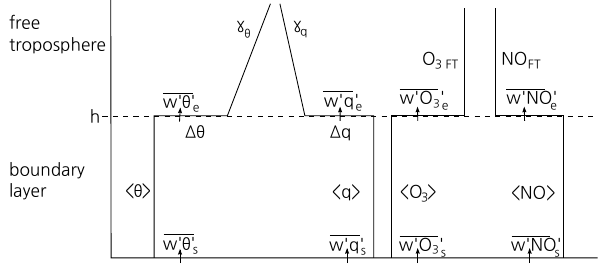
Figure 2. Typical mixed-layer profiles of potential temperature ( θ ), specific humidity ( q ) and chemical species (in this case O 3 and NO). Also surface and entrainment fluxes of heat, moisture, O 3 and NO are indicated; the arrows indicate the direction in which the flux is defined